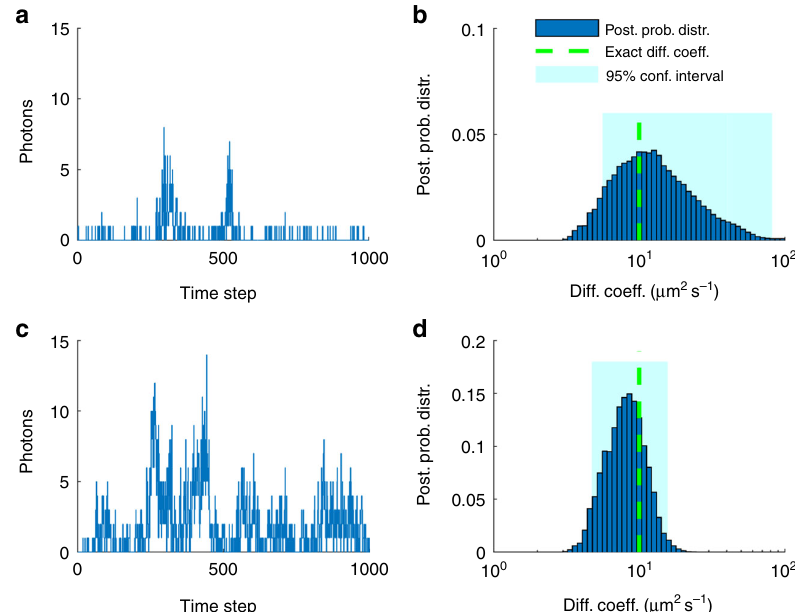
Fig. 1 Effects of the number of molecules. a Synthetic fl uorescent intensity trace produced by one molecule inside the confocal volume. For this simulation we used a molecular brightness of 5×10 4 photons s − 1 and a background photon emission rate of 10 3 photons s − 1 . b Posterior probability distribution over the diffusion coef fi cient estimated from the trace in a . c Synthetic fl uorescent intensity trace produced by fi ve molecules inside the confocal volume otherwise identical to a . d Posterior probability distribution over the diffusion coef fi cient estimated from c . Traces shown in a , c are acquired at 100 μ s for a total of 100 ms and the highlighted regions in b and d represent the 95% con fi dence intervals. For clarity, the horizontal axis is shown in logarithmic